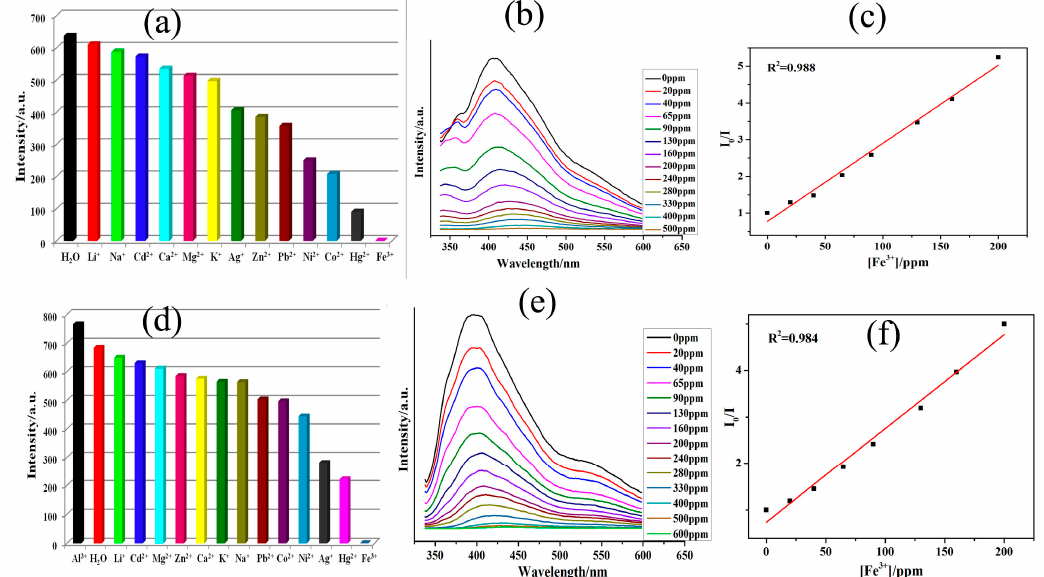
Figure 2. ( a ) The photoluminescence intensity of 1 dispersed in different metal ions solutions ( λ ex = 280 nm); ( b ) the emissive response spectra of 1 for aqueous Fe 3+ solution with different concentrations; ( c ) the Stern–Volmer plot for Fe 3+ in presence of 1 ; ( d ) the Photoluminescence intensity of 2 dispersed in different metal ions solutions ( λ ex = 280 nm); ( e ) the emissive response spectra of 2 for aqueous Fe 3+ solution with different concentrations; and ( f ) the Stern–Volmer plot for Fe 3+ in presence of 2 .